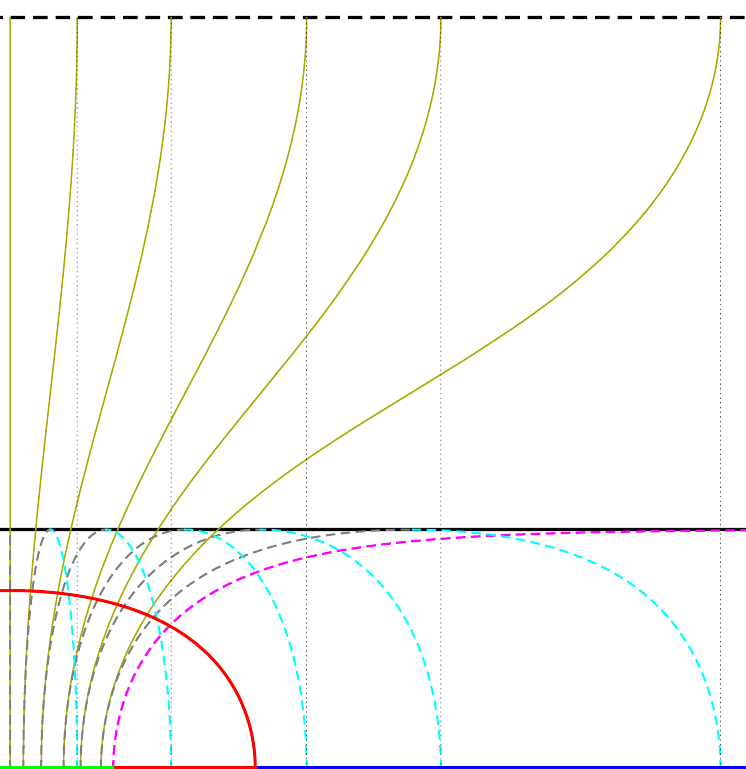
Figure 9 . Comparison between geodesic bit threads (grey dashed curves) connecting a point x A ∈ A β to a point on the horizon (see also figure 7) and the corresponding lines (starting at the same x A ’s) of the modular evolution in the Euclidean spacetime (yellow solid curves, see also figure 5).